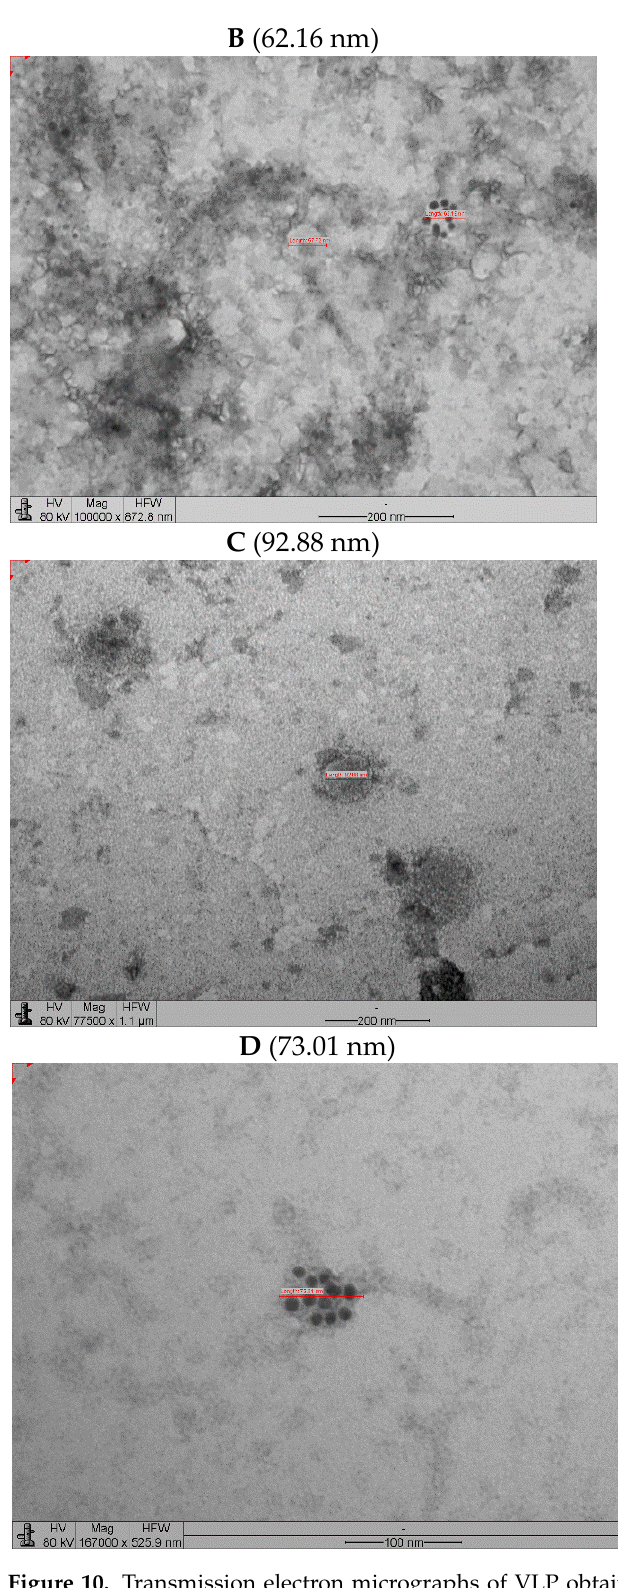
Figure 10. Transmission electron micrographs of VLP obtained in Schott flask and bioreactor at BVM MOI of 2 pfu/cell and BVG MOI of 3 pfu/cell. ( A ) Micrograph of VLP produced in Schott flask without immunostaining. ( B ) Micrograph of VLP produced in Schott flask with immunostaining (ant- G). ( C ) Micrograph of VLP produced in benchtop bioreactor without immunostaining. ( D ) Micrograph of VLP produced in benchtop bioreactor with immunostaining (anti-G).